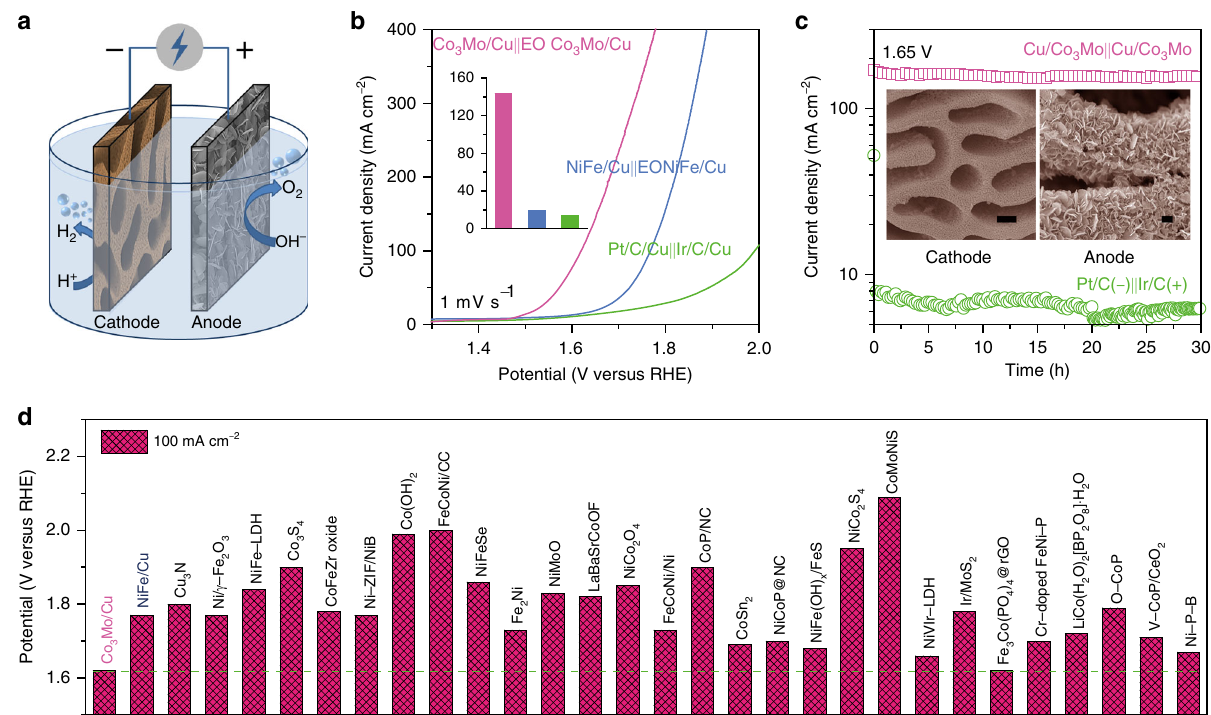
Fig. 5 Electrochemical performance in water splitting. a Schematic illustration of water splitting powered by electric energy, where an alkaline electrolyzer is constructed with nanoporous Co 3 Mo/Cu and EO Co 3 Mo/Cu electrodes as cathode and anode, respectively. b Polarization curves for electrocatalytic overall water splitting of the devices constructed with nanoporous Co 3 Mo/Cu and EO Co 3 Mo/Cu electrodes, nanoporous NiFe/Cu and EO NiFe/Cu electrodes, or Pt/C/Cu and Ir/C/Cu, in the aqueous electrolyte of 1 M KOH and 0.5 M NaCl. Inset: Comparison of current density at 1.65 V. c , Durability test of the electrolyzer constructed with nanoporous Co 3 Mo/Cu and EO Co 3 Mo/Cu electrodes at 1.65 V, comparing with that of the device assembled with Pt/C/Cu and Ir/C/Cu. Inset: Typical SEM images of nanoporous Co 3 Mo/Cu cathode and EO Co 3 Mo/Cu anode after durability test. Scale bar: 400 nm. d Comparison of working voltage of nanoporous Co 3 Mo/Cu-based alkaline electrolyzer at the current density of 100 mA cm − 2 with the values of the ones reported